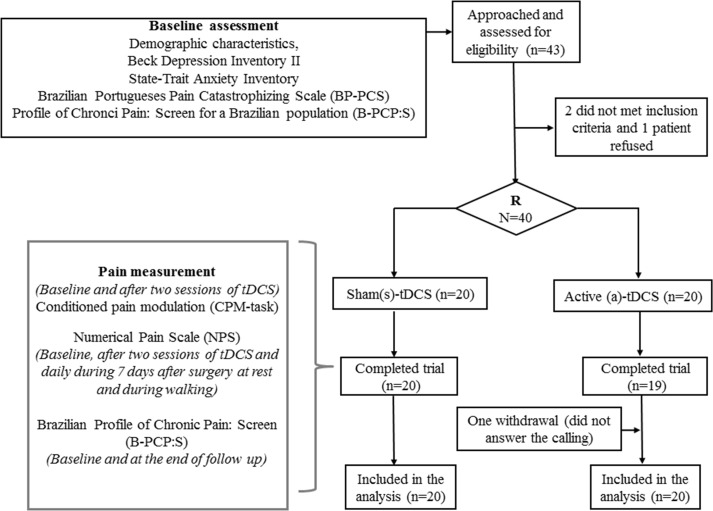
Randomization and follow-up of study subjects.